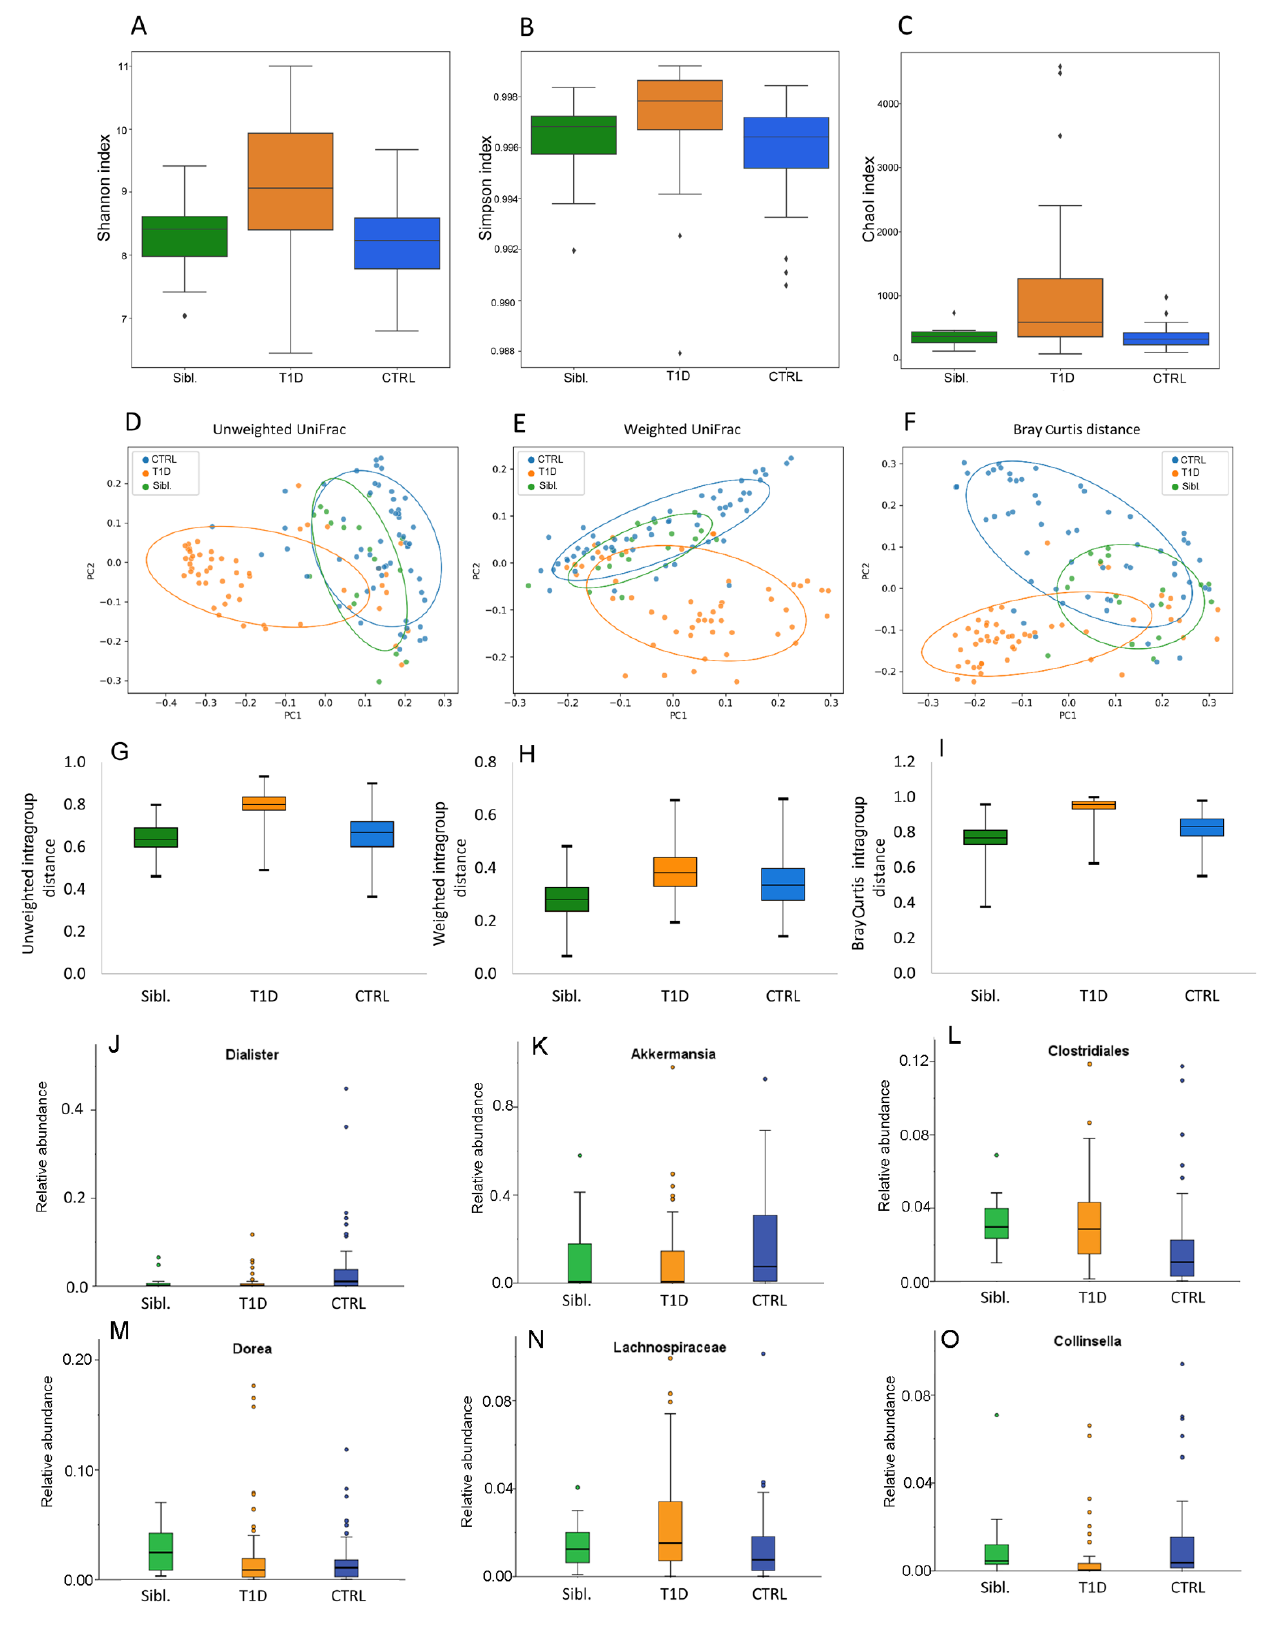
Figure 2. Gut microbiota ecology for siblings, T1D and CTRL groups. Panels ( A – C ): α -diversity Shannon, Simpson and ChaoI indexes. Panels ( D – F ): β -diversity PCoA plots of distance matrices calculated by unweighted UniFrac, weighted UniFrac and Bray Curtis algorithms. Panels ( G – I ):